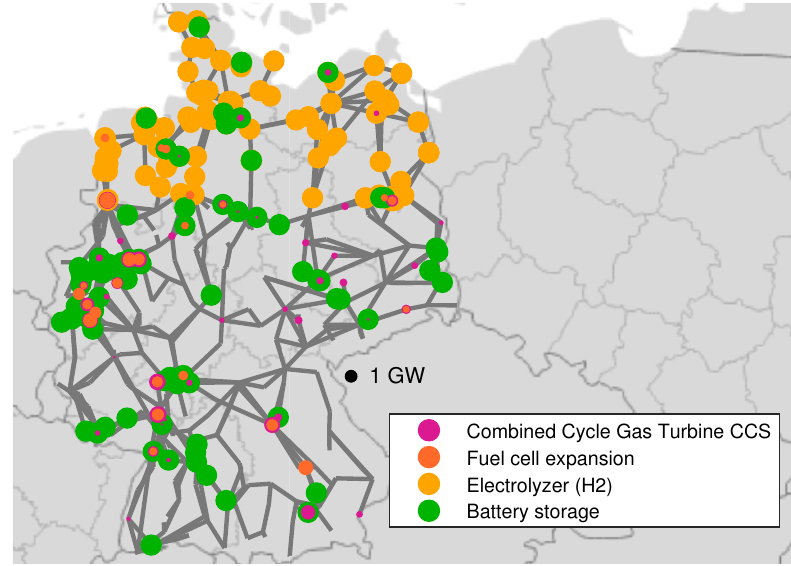
Figure 7. New technologies considered in the exemplary scenario.